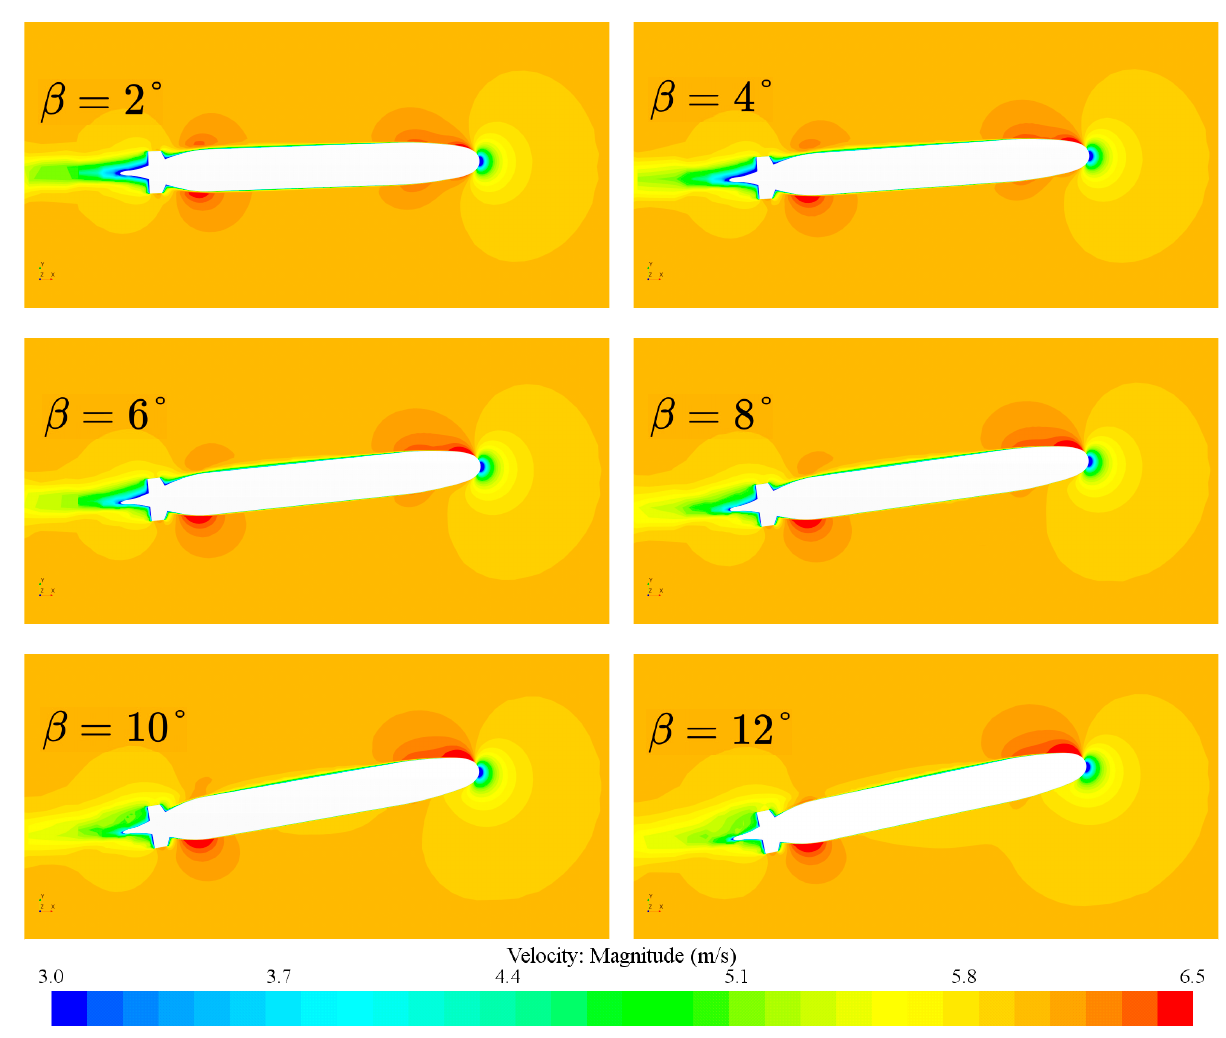
Figure 9. Comparison diagram of velocity field around different drift angle.